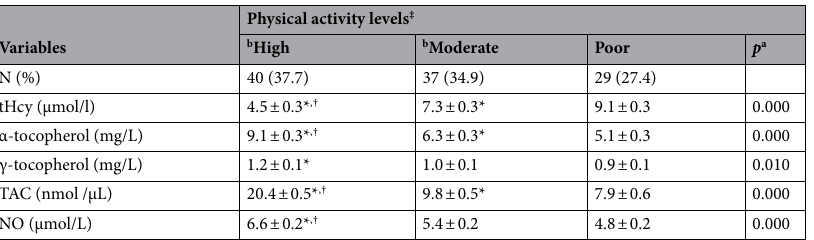
Table 2. Associations between biomarkers (total homocysteine, α-tocopherol, γ-tocopherol, and oxidative stress markers) and physical activity levels in older adults (n = 106). Values are expressed as mean ± SE (adjusted scores). TAC, total antioxidant capacity (nmol/μL); tHcy, total homocysteine levels (μmol/L); NO, nitric oxide. *Significant difference between high or moderate and poor activity levels. † Significant difference between high and moderate activity levels ‡ Age, sex, Educational level, and sex were used as a covariate. a Analysis of covariance (ANCOVA). b Adjustment for multiple comparisons (Bonferroni).